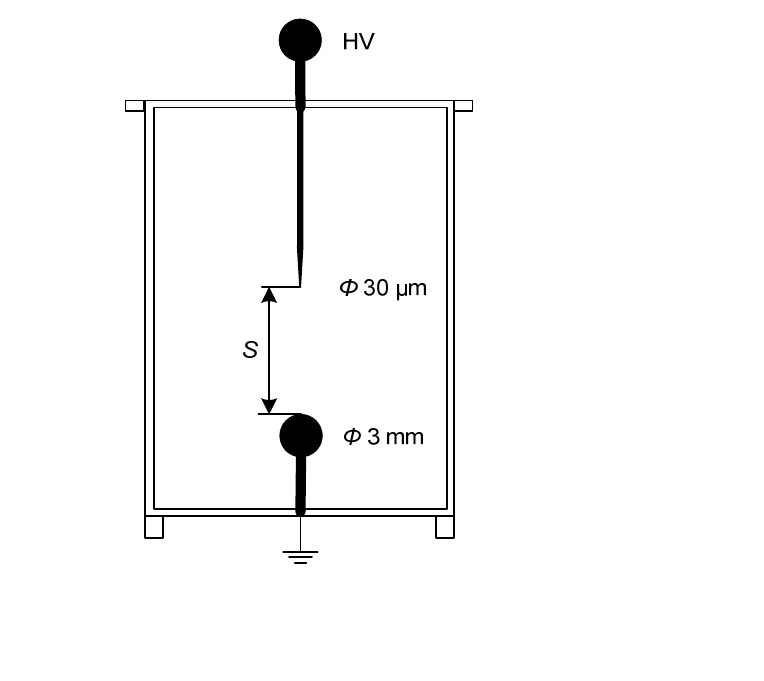
Figure 2. Schematic diagram of the experimental test